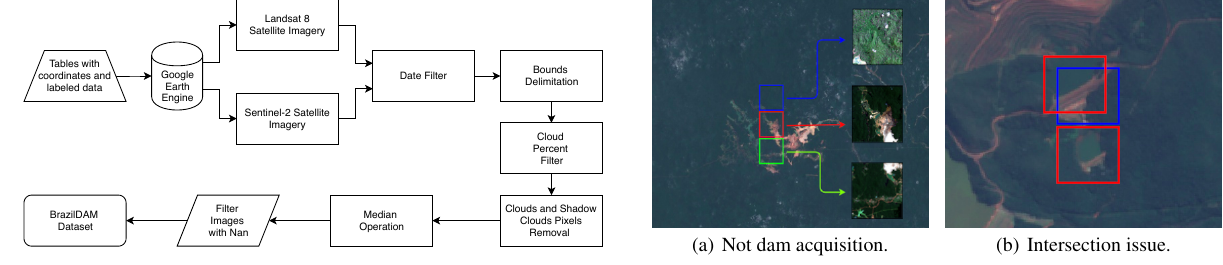
Figure 2. Explanation of not dam images acquisition and intersection issues.